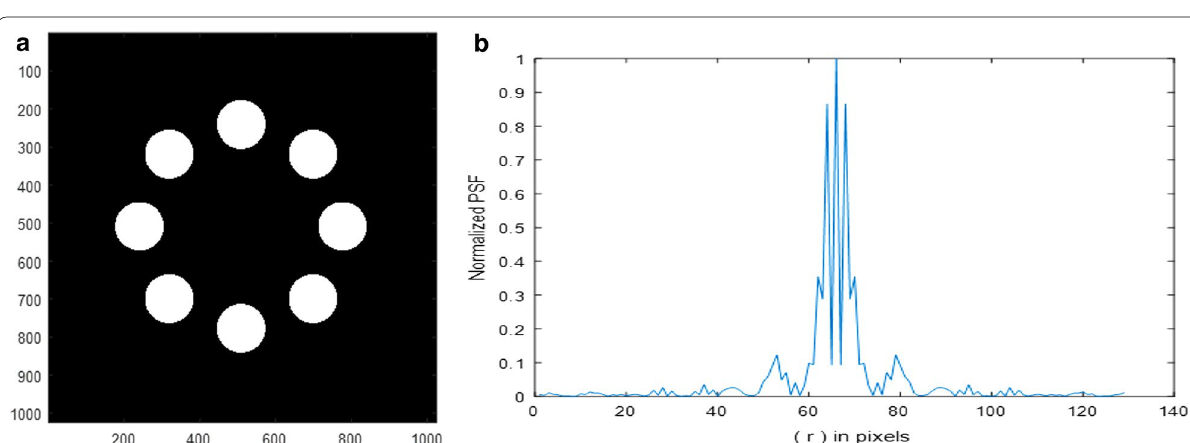
268 pixels from the center placed at (512, =